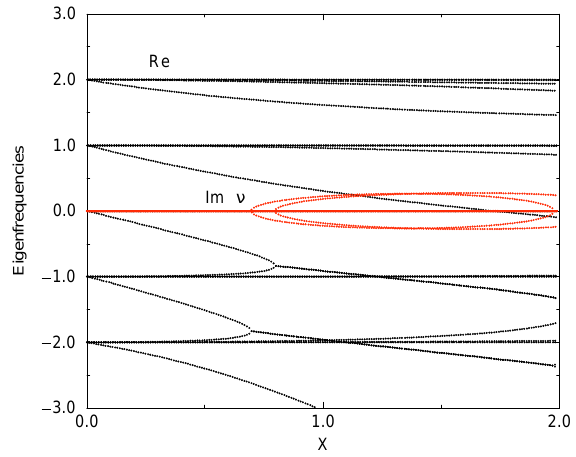
FIG. 2. (Color) Eigenfrequencies (real parts in black, imaginary in red) of transverse oscillations versus (cid:88) (cid:173) (cid:78)(cid:101) (cid:50) b (cid:87) (cid:121) (cid:50) p (cid:50) g (cid:109)(cid:99) (cid:50) (cid:84) (cid:48) . The parameter (cid:80) s (cid:173) (cid:48) .